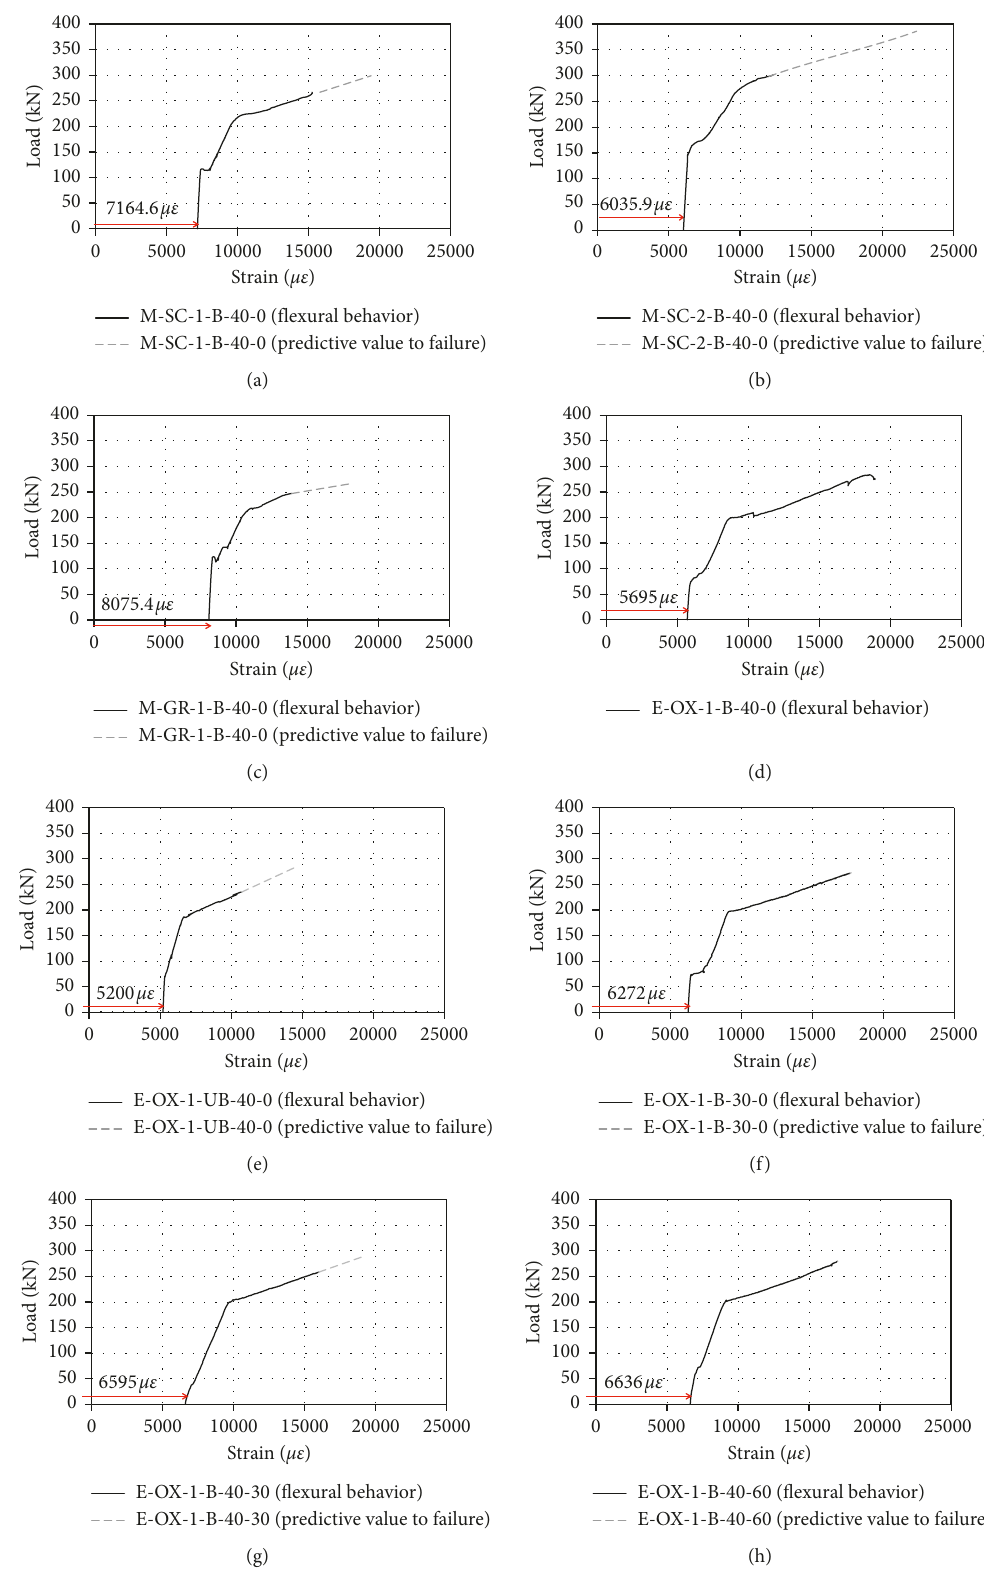
Figure 20: Strain distribution of tendon according to change in post-tension force. (a) M-SC-1-B-40-0. (b) M-SC-2-B-40-0. (c) M-GR-1-B- 40-0. (d) E-OX-1-B-40-0. (e) E-OX-1-UB-40-0. (f) E-OX-1-B-30-0. (g) E-OX-1-B-40-30. (h)